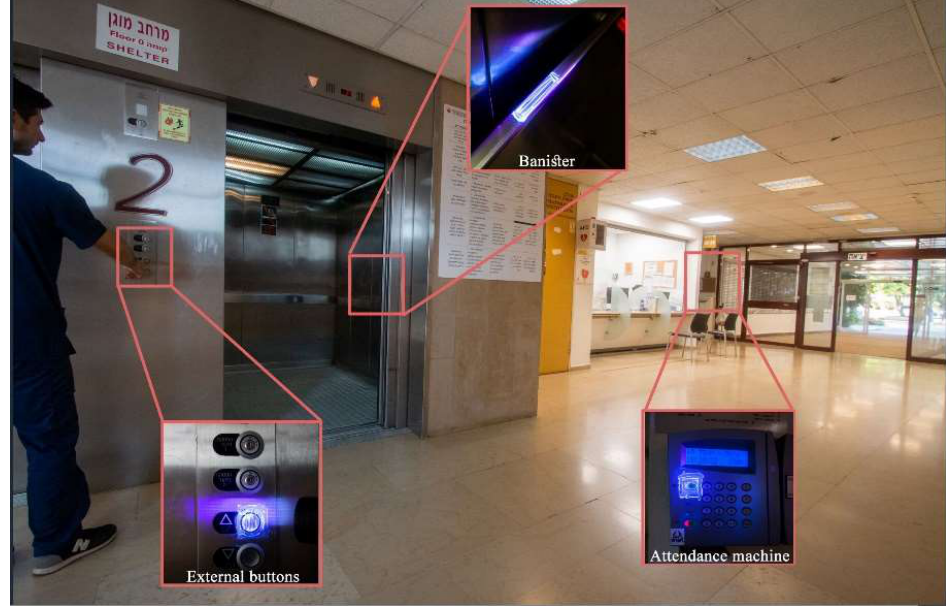
Figure 4. Example of surfaces examined in the school’s public areas.